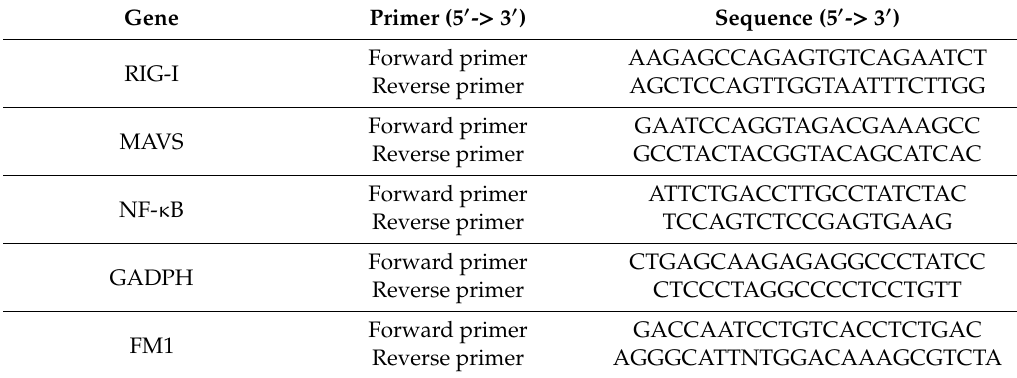
Table 1. Primers used for quantitative reverse transcription polymerase chain reaction (RT-qPCR) analysis.